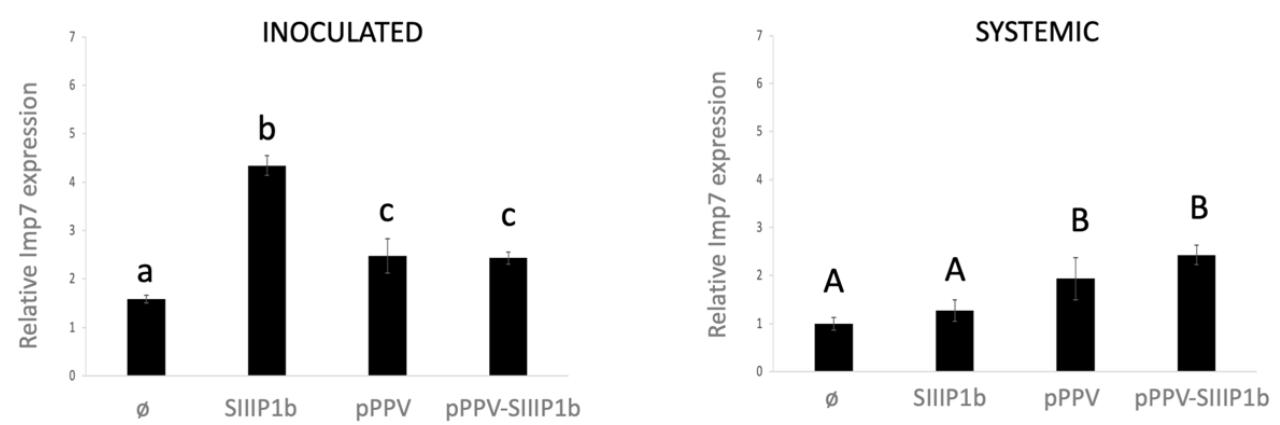
Figure 3. Evaluation of NbImp7 mRNA levels after P1b transient expression or after viral infection. RT-qPCR experiments to assess the mRNA expression of NbImp7, taking as reference the value of this mRNA in upper leaves of mock inoculated plants. Samples of inoculated leaves ( left ) were collected at 6 dpa; samples of systemically infected leaves ( right ) were collected at 12 dpa. Analysis of variance ( n = 4; p < 0.05) (one-way ANOVA), followed by Tukey´s post hoc test, was performed; and letters indicate the different groups.